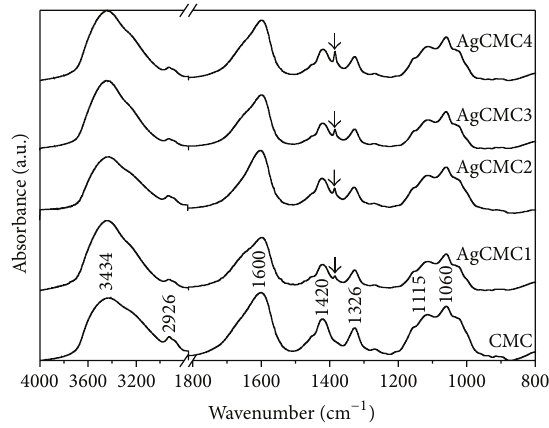
Figure 4: FTIR spectra obtained from the samples AgCMC1, AgCMC2, AgCMC3, and AgCMC4, as well as that recorded from native